Question: Write a descriptive caption for this figure.
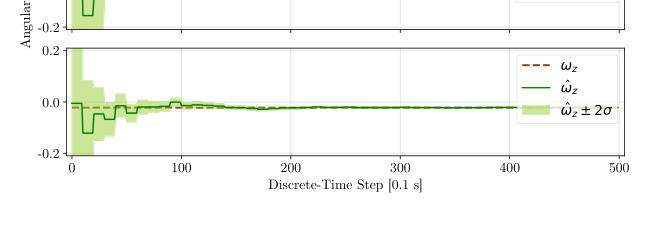
Answer: Uncertainties of the EKF angular velocity estimates using the trained parameters from DS1 on DS1. Each of the three subplots depicts one of the components of the angular velocities. In every subplot, the EKF estimate and the corresponding ground truth, denoted as ˆx and x, and the uncertainty space are plotted. For the uncertainty space, the double standard deviation (2σ) of the corresponding error state feature is utilized.